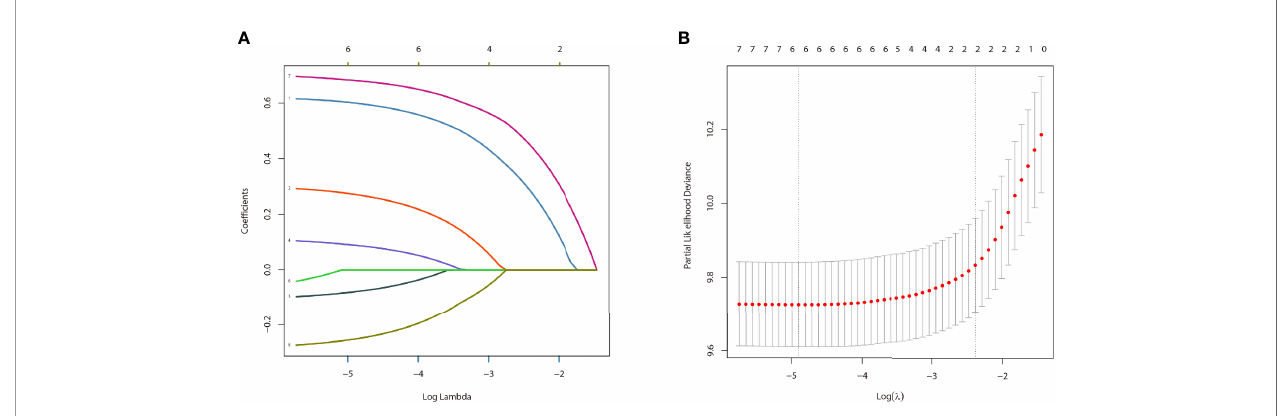
FIGURE 2 | The result of the lasso regression (A, B)